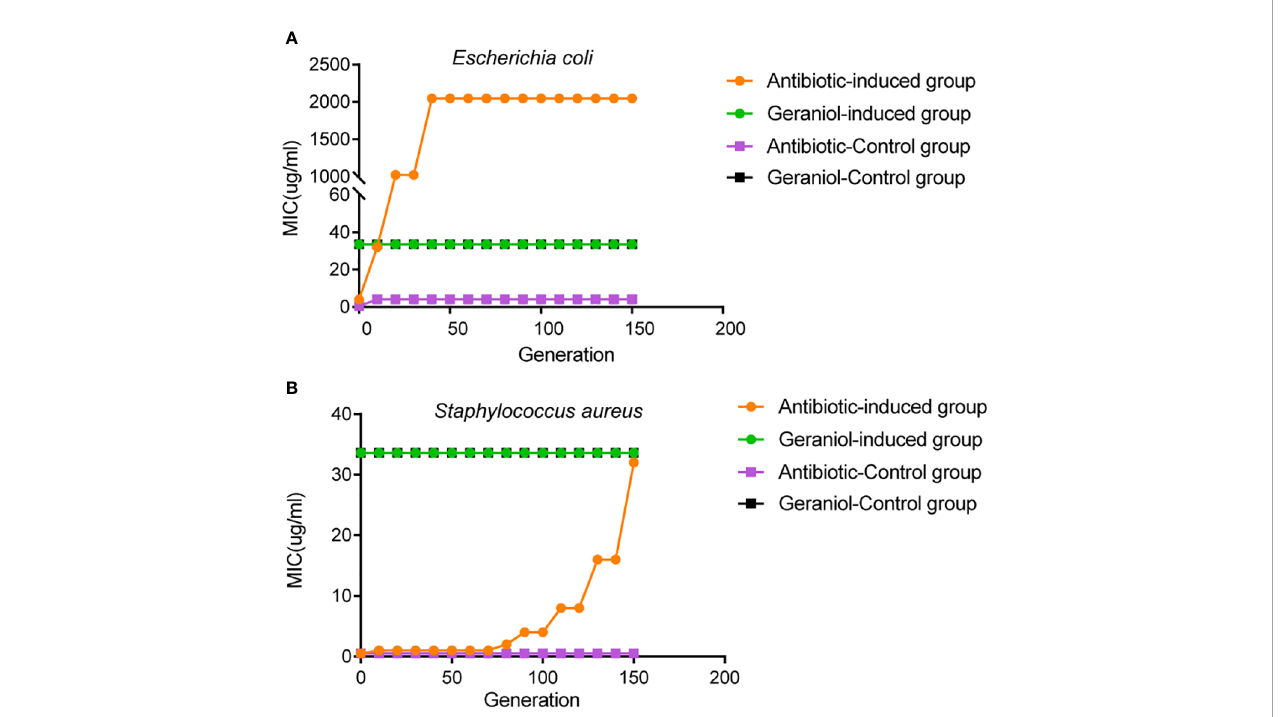
FIGURE 10 Effects of drug resistance of bacteria to geraniol and amoxicillin via passage cultivation with sub-inhibitory concentrations of drug. (A) Dynamic changes of MIC value of geraniol to the Escherichia coli strain ATCC25922 from 1-150 generations of subculture at 1/2MIC. (B) Dynamic changes of MIC value of amoxicillin to the Staphylococcus aureus strain ATCC25923 from 1-150 generations of subculture 1/2MIC.